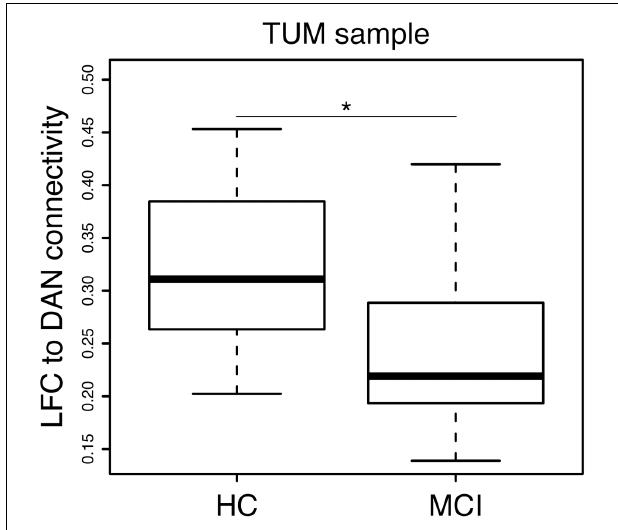
FIGURE 3 | Significant group difference (MCI vs. HC) in LFC-connectivity to the DAN in the TUM